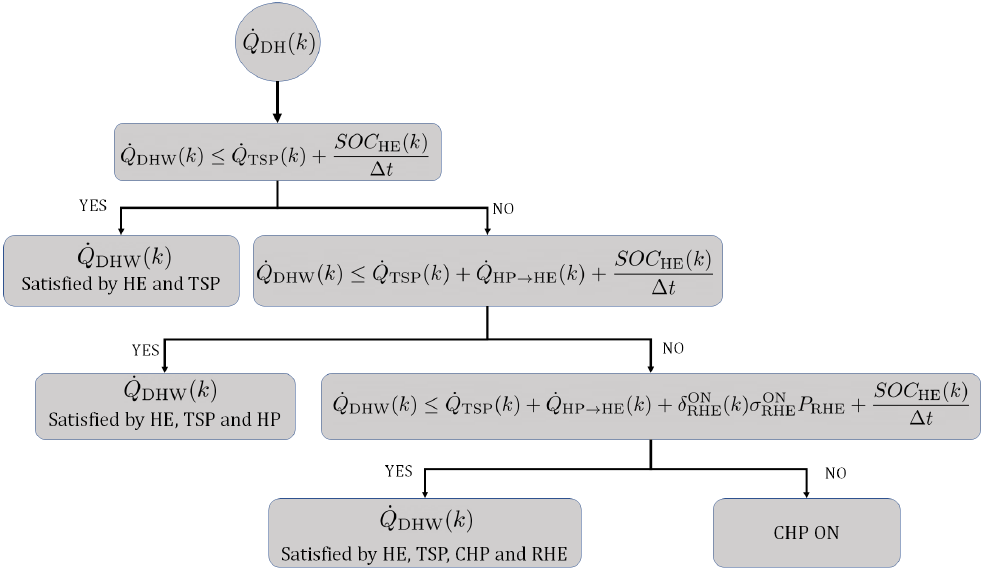
Figure 4. Hot water demand satisfaction